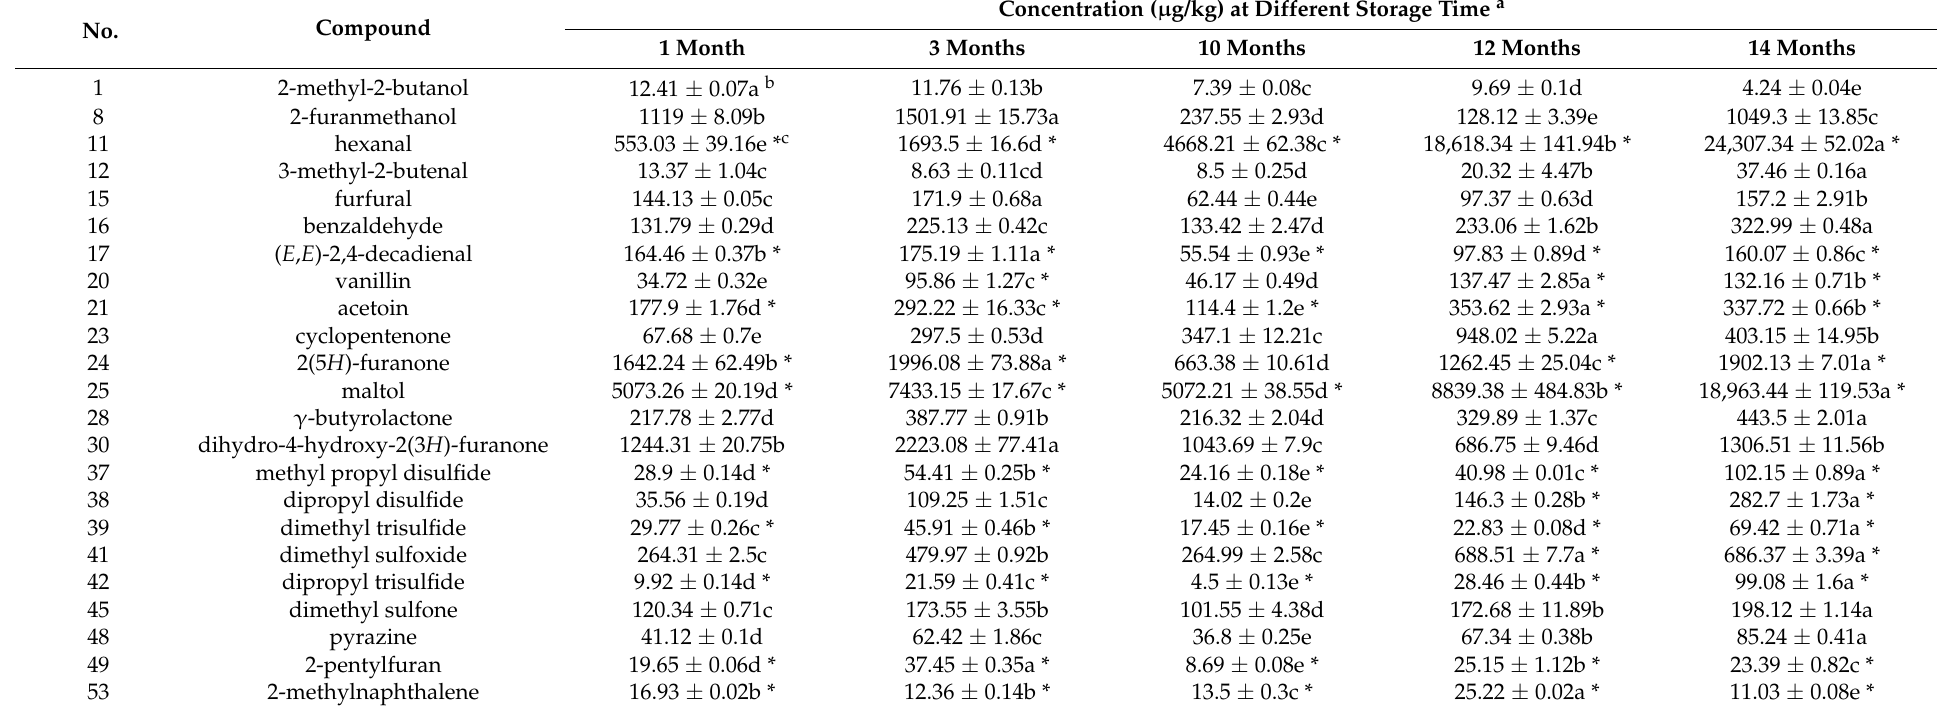
Table 4. Concentration changes of potent odorants during storage in